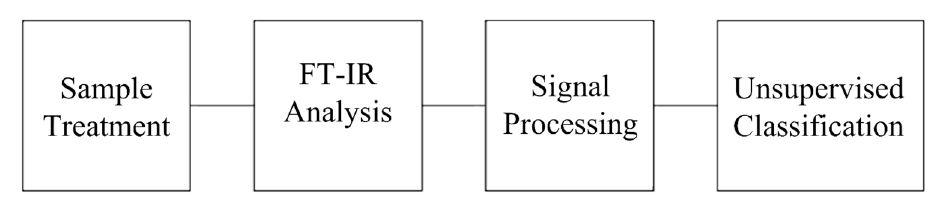
Figure 3. Workflow of sample acquisition and data analysis.